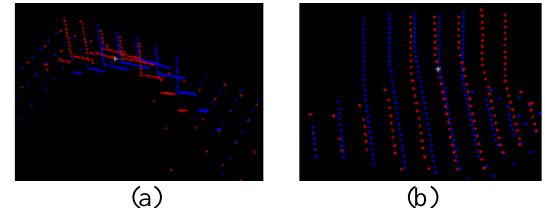
Figure 5 (a) Top-back view of the target after registration; (b) front view of the target after registration